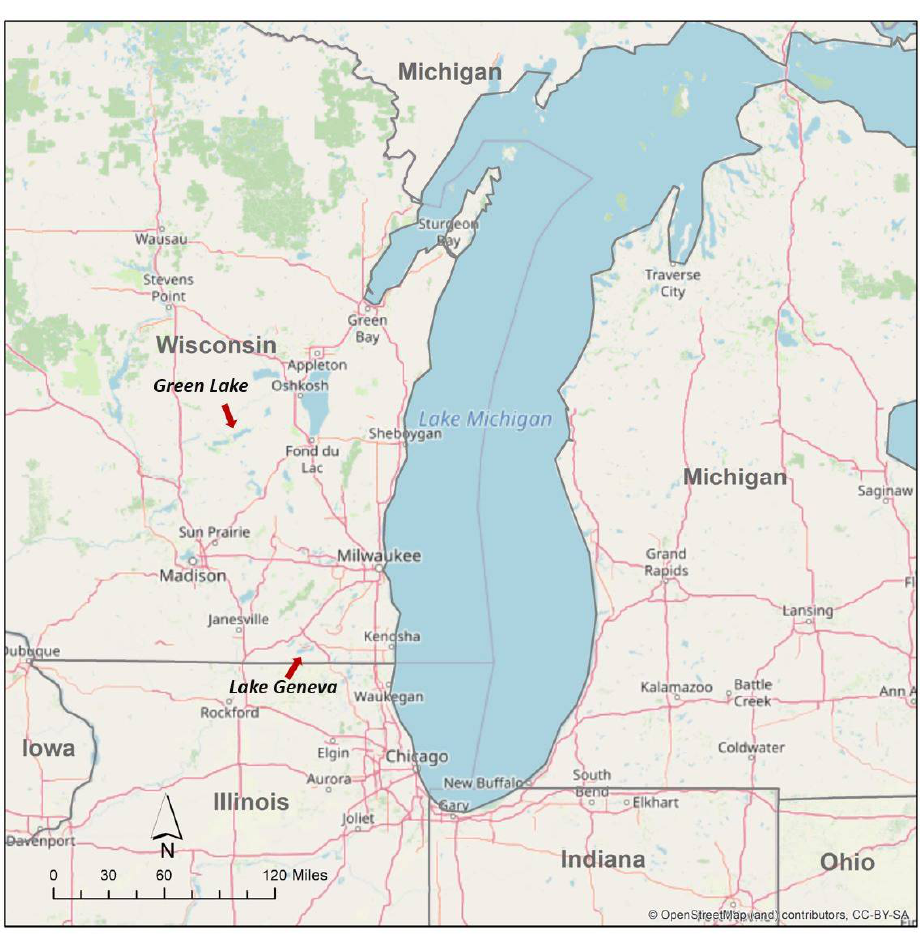
Figure 1. Location of Green Lake and Lake Geneva in Wisconsin.